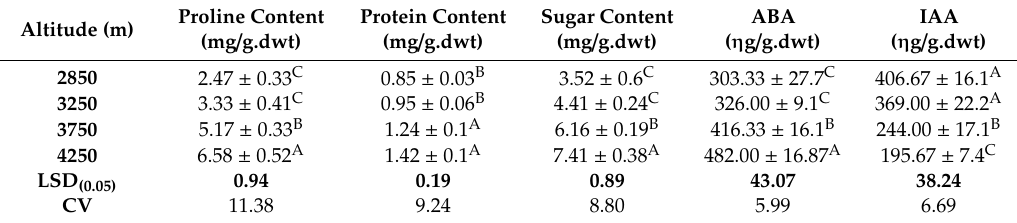
Table 3. Ecophysiological plasticity observed in Sibbaldia procumbens through the analysis of protein, sugar and proline, protein, and sugar contents, and ABA and IAA concentrations.